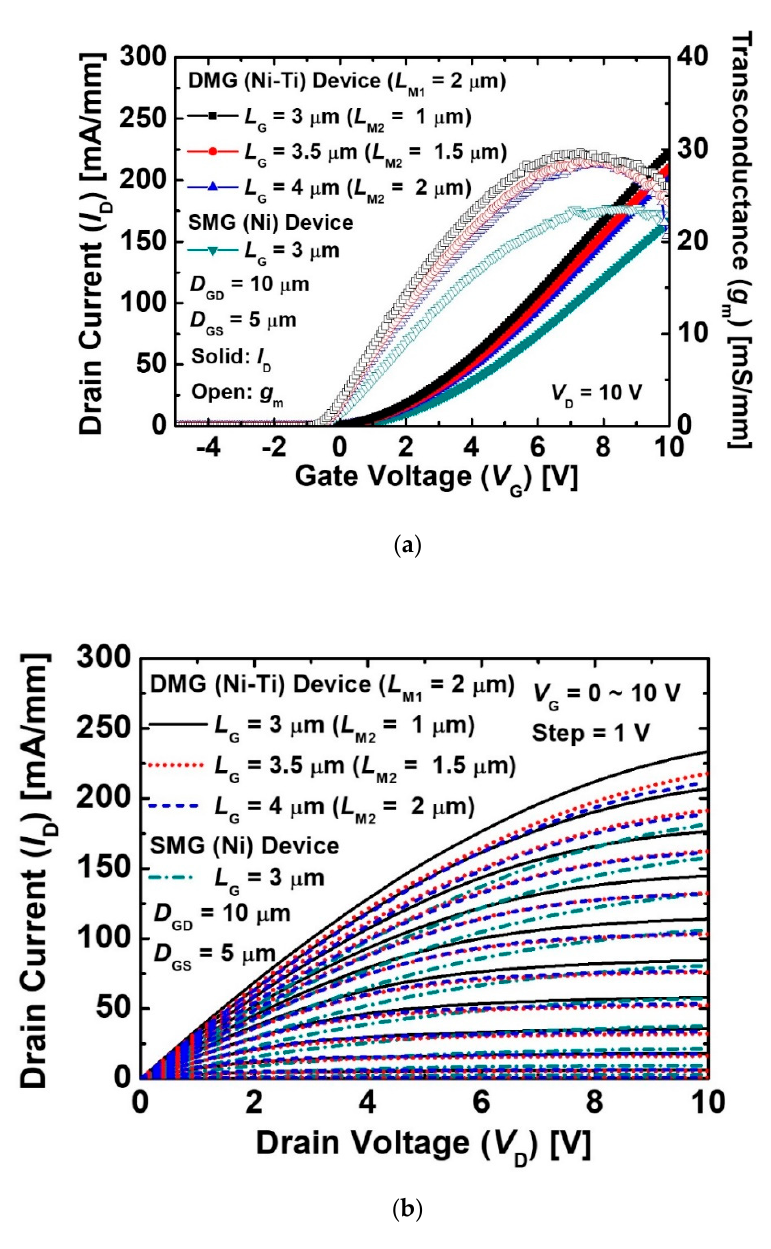
Figure 4. ( a ) Transfer and ( b ) output characteristics of the SMG- and DMG-based devices with different L G . The D GD and D GS of both devices were 10 μ m and 5 μ m, respectively. The M1 and M2 in the DMG structure consist of Ni and Ti,